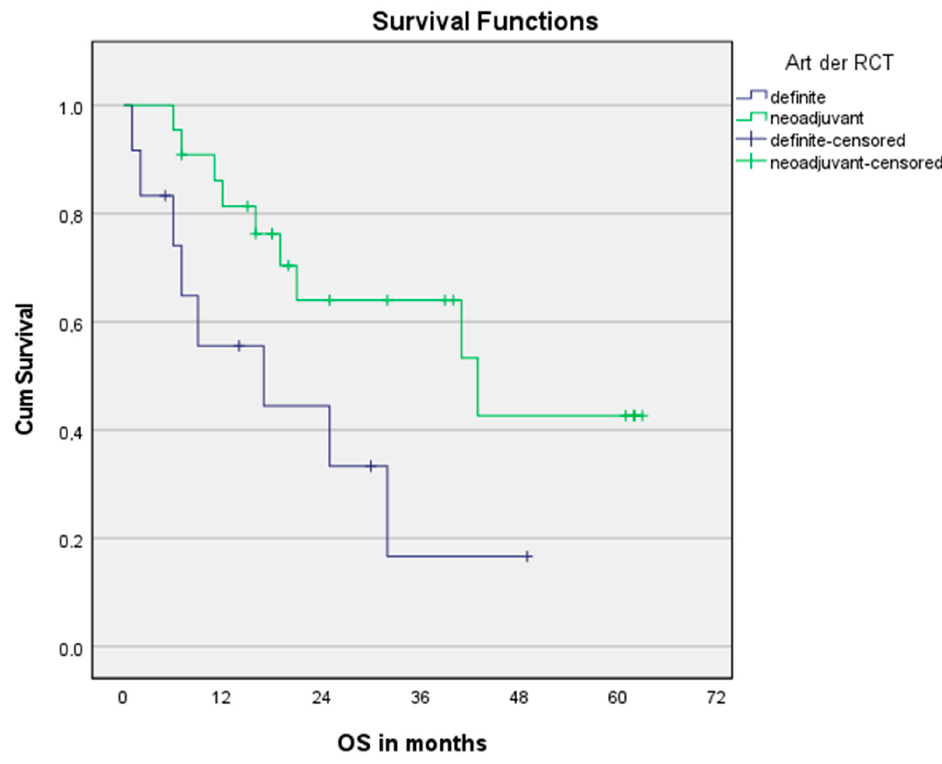
Figure 3. Overall survival for nCRT and dCRT. n = 34. Log Rank (Mantel-Cox): p = 0.049.